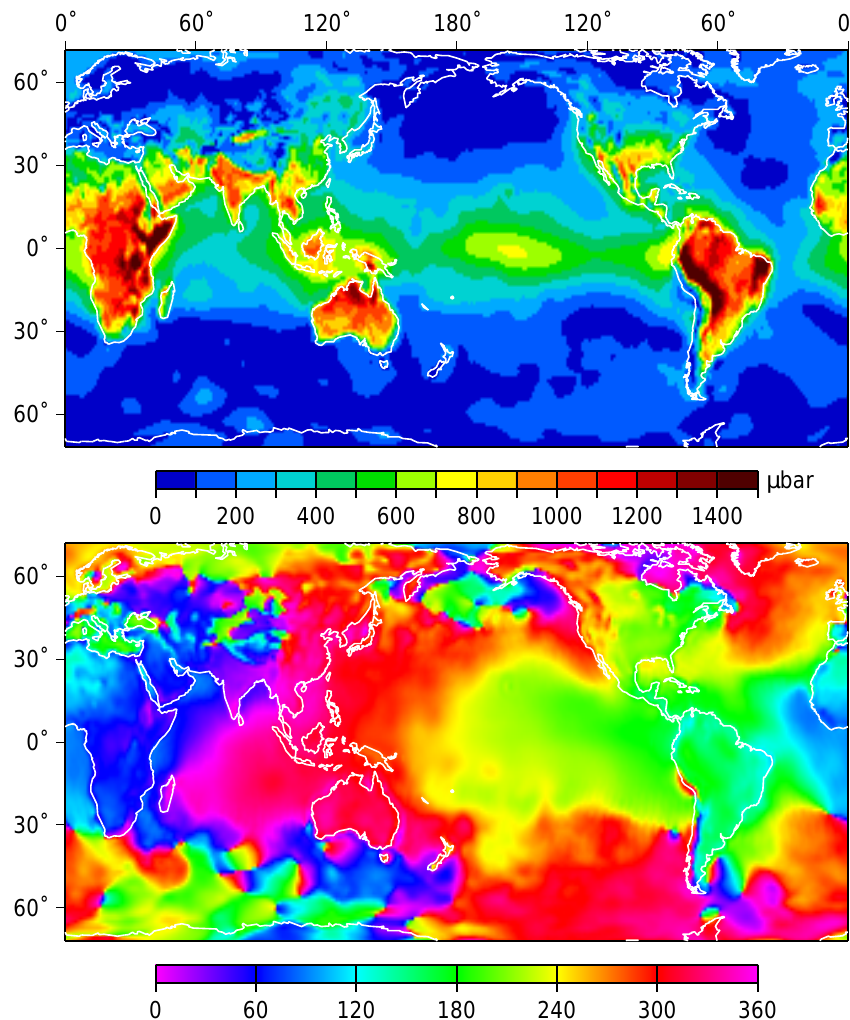
Fig. 8. Amplitude and Greenwich phase lags of the S 1 (p) tide, as deduced from ECMWF surface pressures.